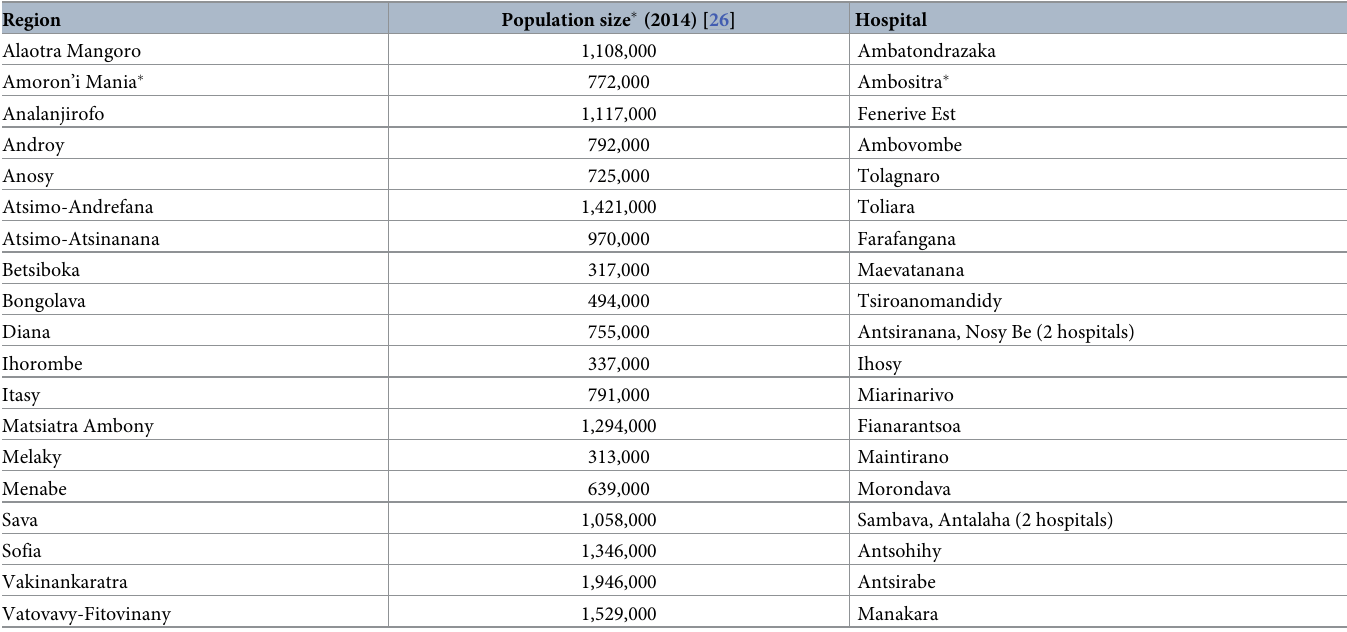
Table 2. Regions, population sizes and hospitals